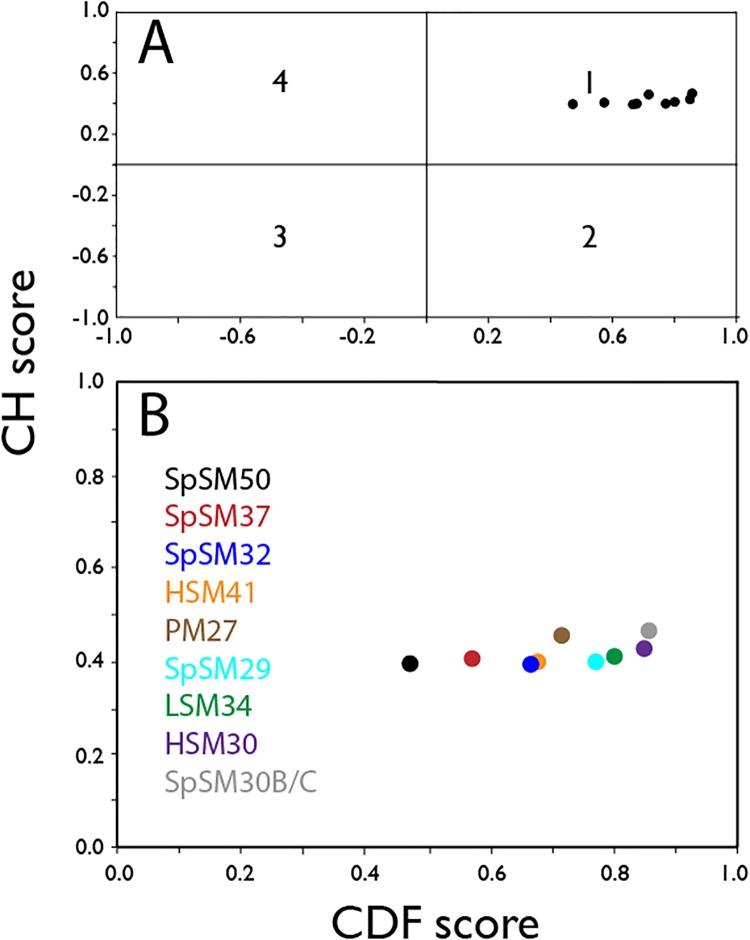
(A) Four quadrant (1–4) CH-CDF plot for spicule matrix protein sequences. (B) Enlargement of relevant Quadrant 1. The Y-coordinate in the CH-CDF plot corresponds to the distance from the obtained ordinate value to the correlation line separating the structured and unstructured conformational state of the protein on the CH (charge-hydrophobicity) plot. The X-coordinate on the CH-CDF plot corresponded to the distance from the obtained ordinate value to the correlation line separating the structured and unstructured conformational state of the protein in the CDF. There are 4 quadrants: Quadrant 1 (CH > 0, CDF > 0) representing rare proteins for which it is impossible to determine accurately the state, i.e., their CDF scores correspond to structured domains but CH scores correspond to unstructured proteins. Quadrant 2 (CH > 0, CDF < 0) represents unfolded proteins (U), Quadrant 3 (CH < 0, CDF < 0) represents the molten globule state (MG). Quadrant 4 (CH < 0, CDF > 0) represents structured or folded proteins (F)[44,45].